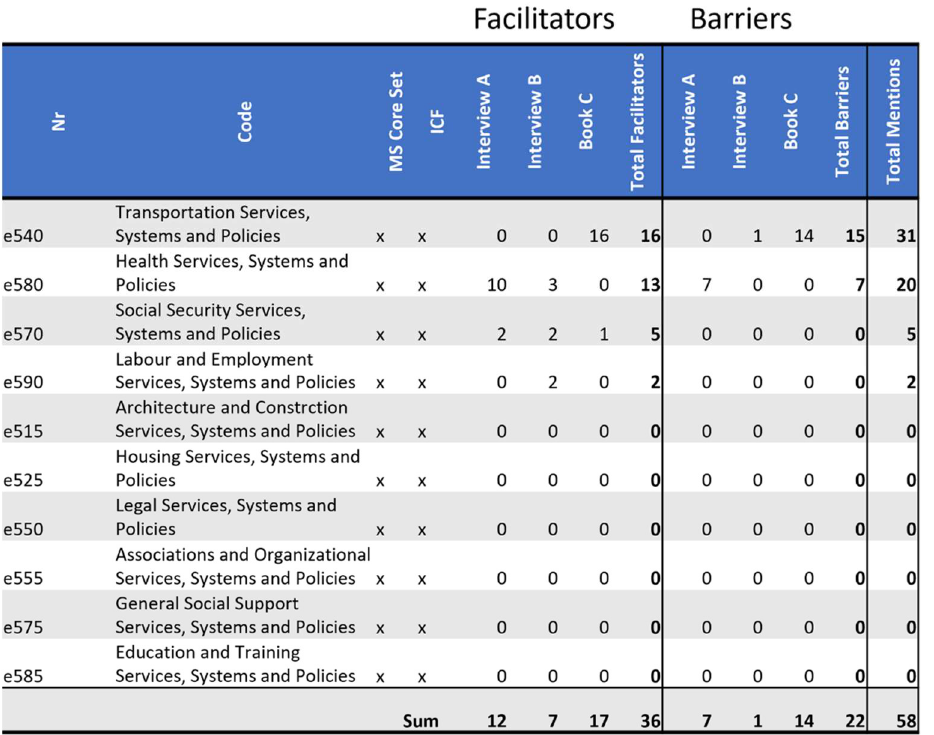
Figure 8. Distribution of codes in the domain e5 Services, Systems and Policies : This figure shows the frequency of MS core set codes and non-core set codes of this domain referenced in each source as a facilitator and as a barrier. Additionally, it tallies all references throughout the domain as facilitators or as barriers by source, as well as tallying facilitators and barriers separately and together by code.